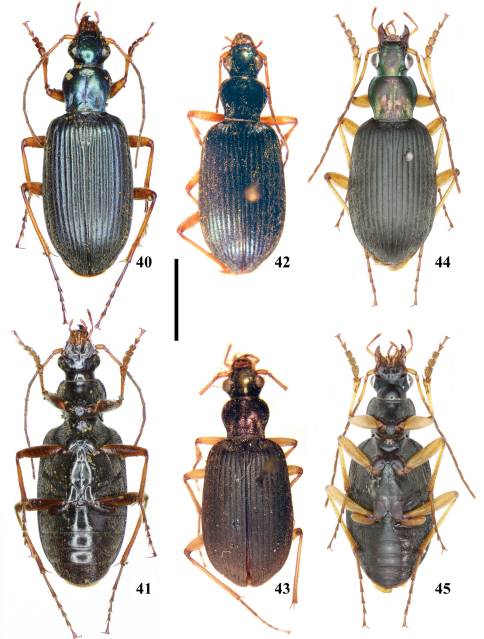
Chlaenius (Lithochlaenius) spp40 Chlaenius nuristanus a. rubridipes Jedlička, paratype, male, in MNHN, dorsal view41 Chlaenius nuristanus a. rubridipes Jedlička, paratype, male, in MNHN, ventral view42 Chlaenius agiloides Jedlička, holotype, male, in NMPC, dorsal view43Chlaenius formosanus Jedlička, holotype, male, in NMPC, dorsal view44 Chlaenius rambouseki Lutshnik, from Taiwan, male, in IZCAS, dorsal view45 Chlaenius rambouseki Lutshnik, from Taiwan, male, in IZCAS, ventral view. Scale line = 5.0 mm.